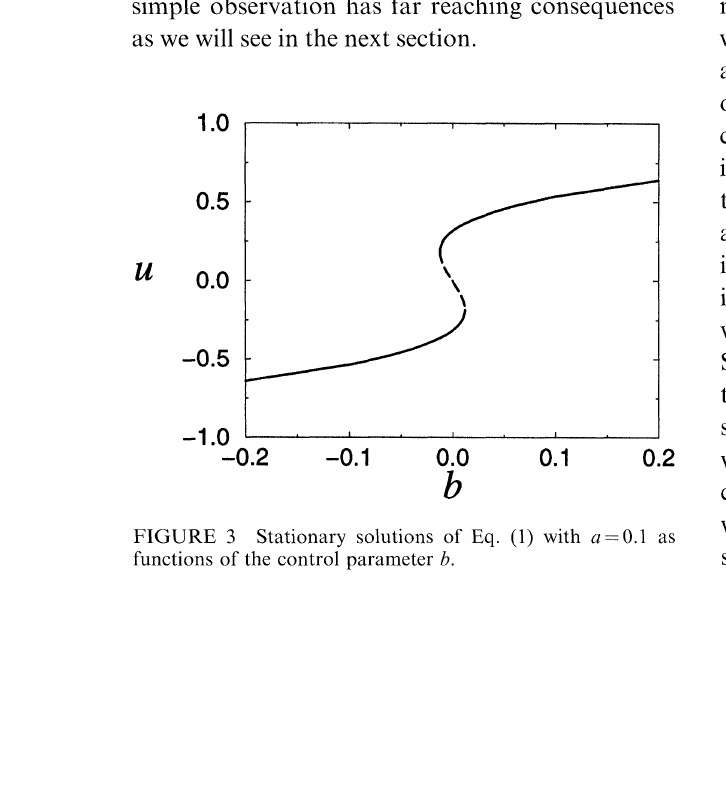
FIGURE 3 Stationary solutions of Eq. (1) with a 0.1 as functions of the control parameter